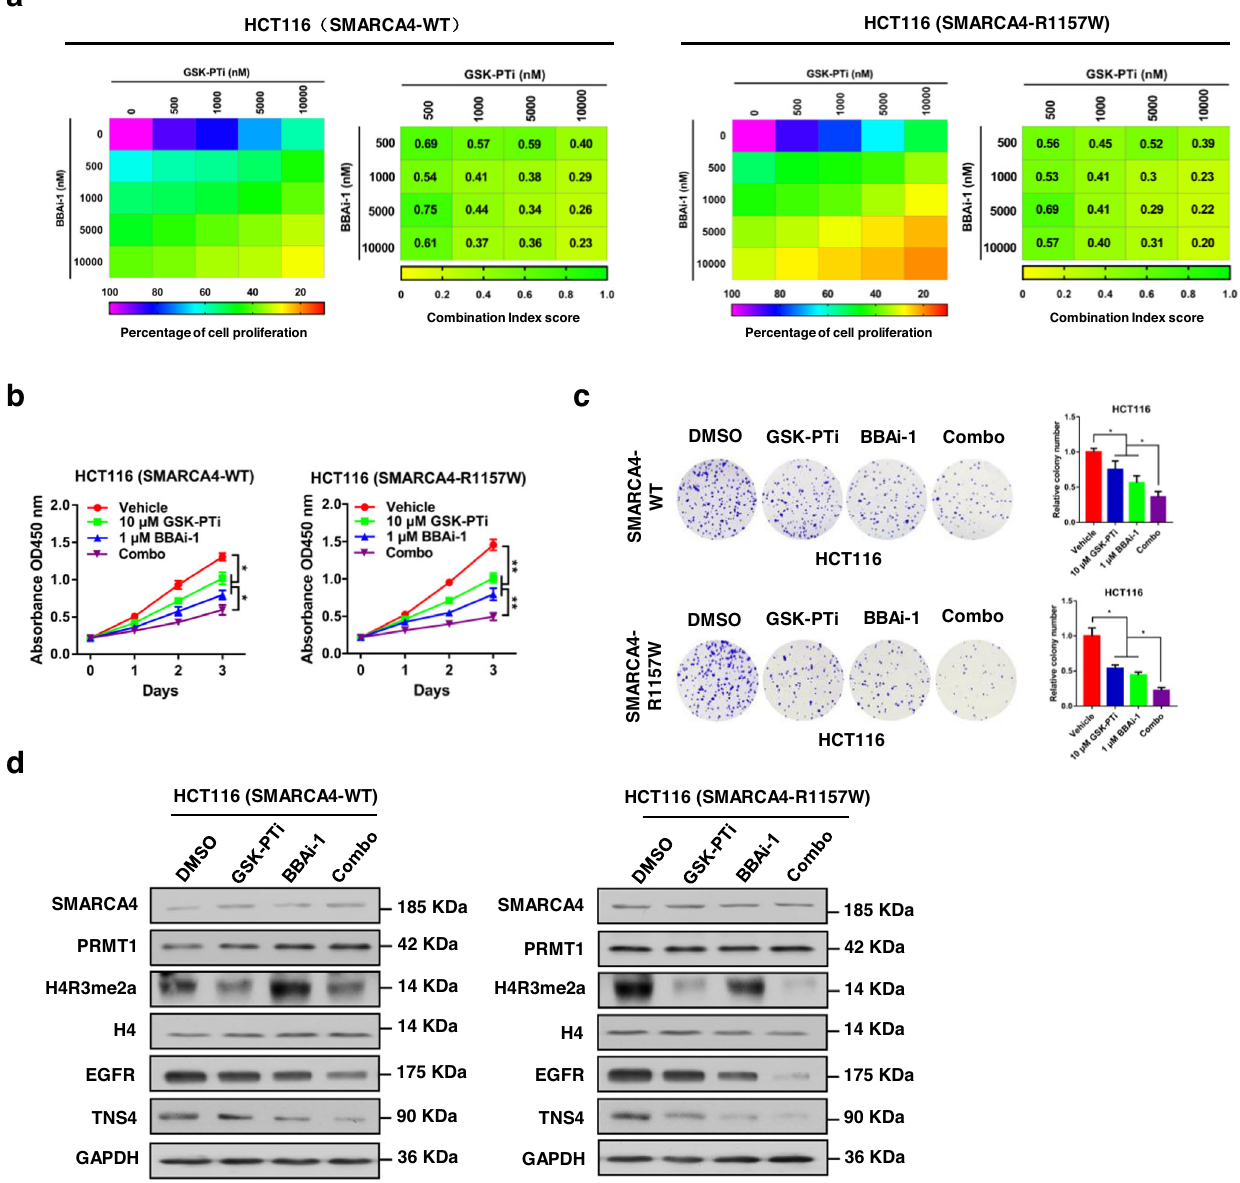
Fig. 5 Synergistic effect of combined treatment with GSK-PTi and BBAi-1 in SMARCA4-R1157W HCT116 cells. a Dose – response matrix for growth inhibition of SMARCA4-WT (left panels) or SMARCA4-R1157W (right panels) HCT116 cells following 7 days of culture with GSK-PTi plus BBAi-1. Color gradation indicates percent viability at the indicated dose combination. Combination index (CI) scores for SMARCA4-WT (left panels) or SMARCA4-R1157W (right panels) HCT116 cells following 7 days of culture with GSK-PTi plus BBAi-1 at the indicated concentrations. Each CI score represents data from at least three independent experiments. b , c CCK8 ( b ) and colony formation ( c ) assays were performed to evaluate the effect of the combination treatment with 10 μ M GSK-PTi or/and 1 μ M BBAi-1 on cell proliferation of SMARCA4-WT or -R1157W HCT116 cells. * P < 0.05, ** P < 0.01. d Western blot analysis of indicated proteins in SMARCA4-WT or -R1157W mutant HCT116 cells following treatment with 10 μ M GSK-PTi or/and 1 μ M BBAi-1. Histone H4 and GAPDH were used as loading controls. In the graphs, the error bars are the standard deviation of the